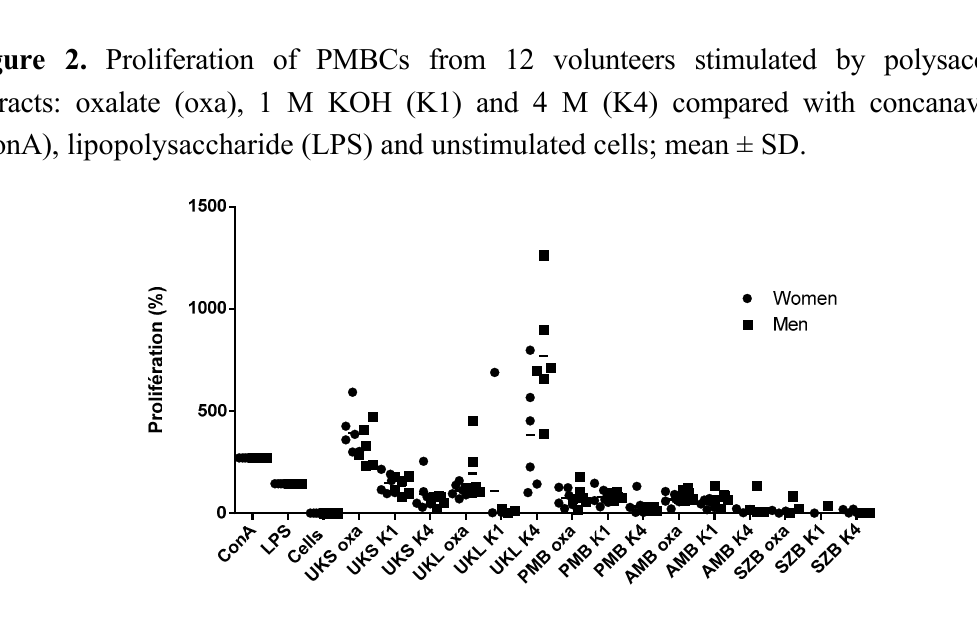
Figure 3. Representation of the dose-response effect of polysaccharide extracts: oxalate (Oxa), 1 M KOH (K1) and 4 M KOH (K4) compared with concanavalin A (ConA) ( n = 6); mean ± SD.